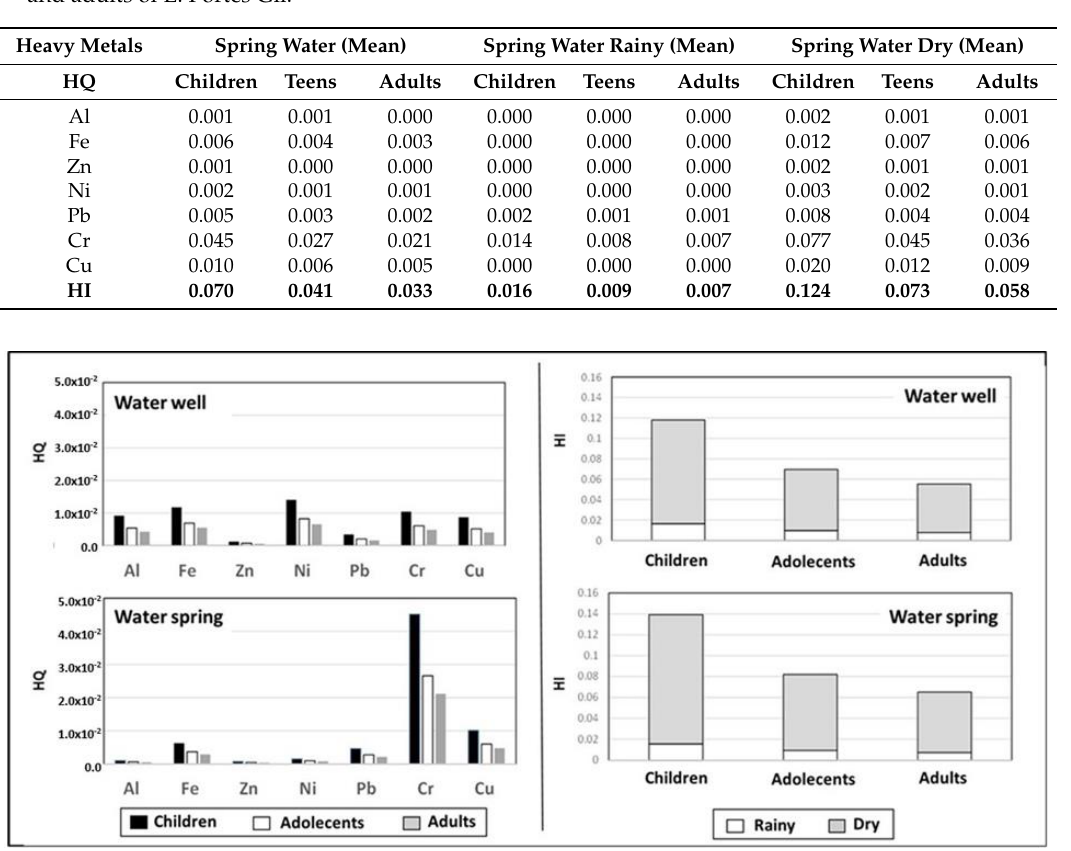
Figure 2. HQ and HI, due to the intake of water from the wells and the spring, considering the different population subgroups (children, teenagers and adults) and seasons (rain and dry).